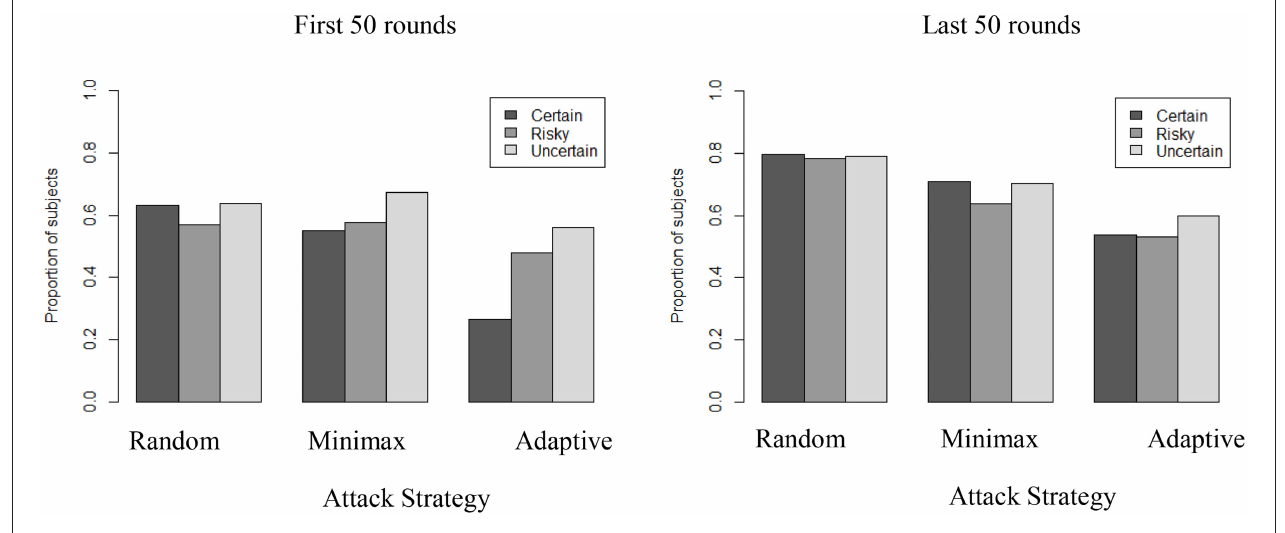
FIGURE 8 | Proportion of players not exhibiting i.i.d behavior across conditions in first and last 50 rounds (Wald-Wolfowitz runs tests, p <